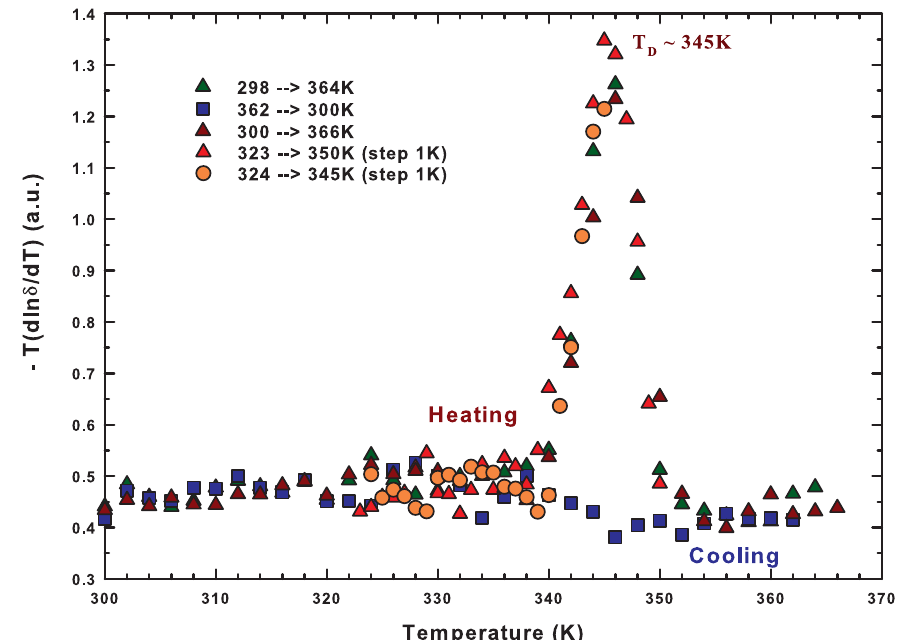
Figure 5. The configurational specific heat obtained by the derivative of the natural logarithm of the proton chemical shift (measured by 1 H HR-MAS NMR) with respect to the temperature. We report both the heating and cooling paths for the complete cycle that goes beyond the denaturation and the heating path of other partial cycles. Figure adapted from Reference